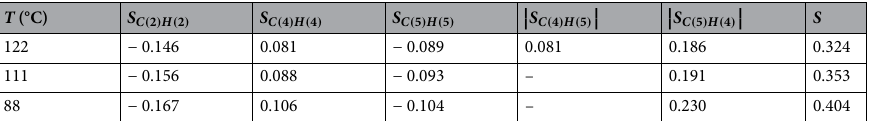
Table 1. Experimental C–H local order parameters S CH in imidazolium ring and cation order parameter S . Signs of the parameters S C ( 4 ) H ( 5 ) and S C ( 5 ) H ( 4 ) were not available from the experimental data. The model analysis suggested positive signs for these two